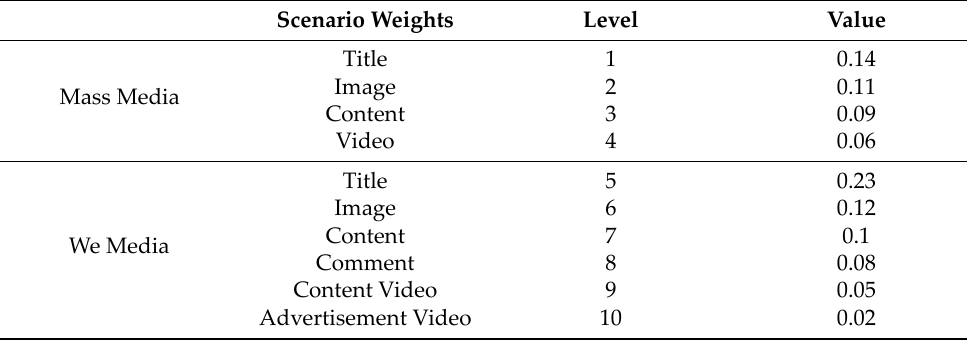
Table 7. The Definition of the Word Scene Coefficient Vector of Luckin